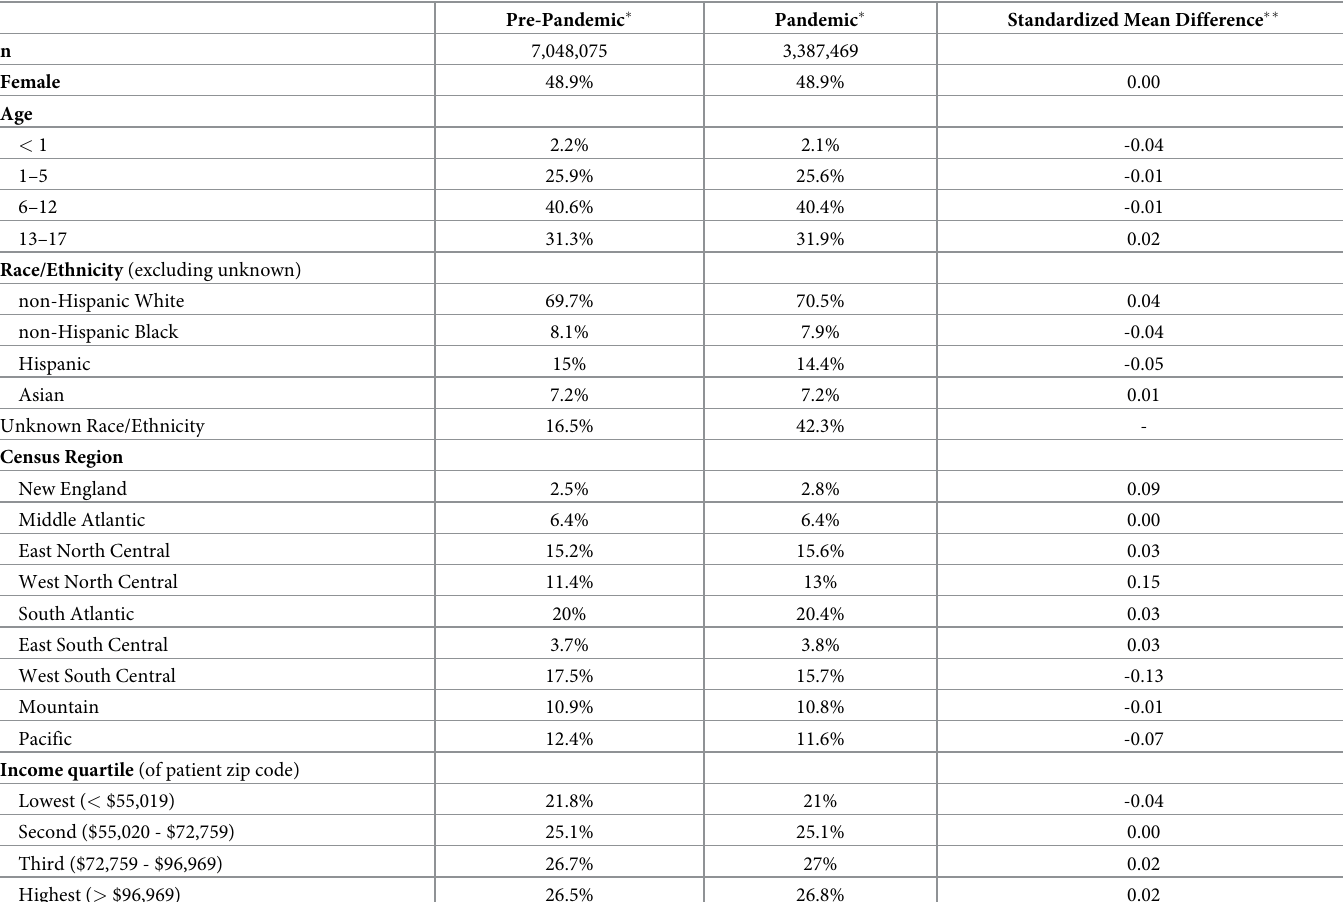
Table 1. Demographic characteristics of the study